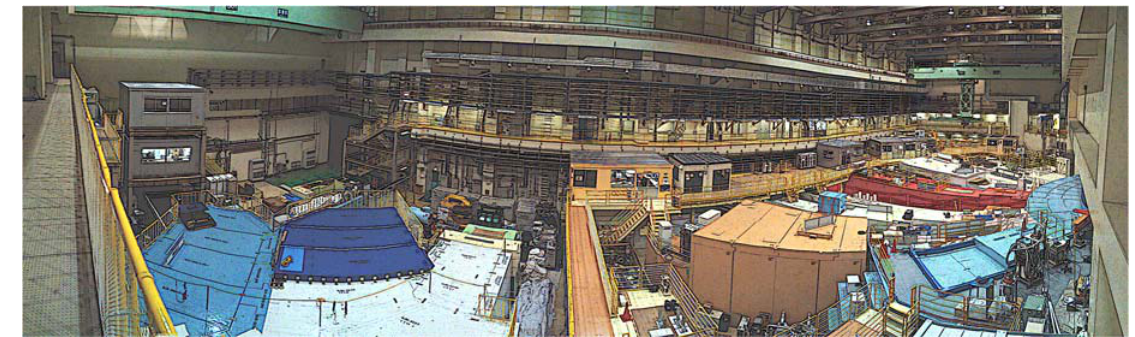
Figure 1. Artistic panoramic view into an experimental hall of the Materials and Life Science Facility at J-PARC [2–5]. The neutron beam ports surrounding the target station are to the far right feeding beamlinces at the right, while muon apparatus is located in the left side of the image.